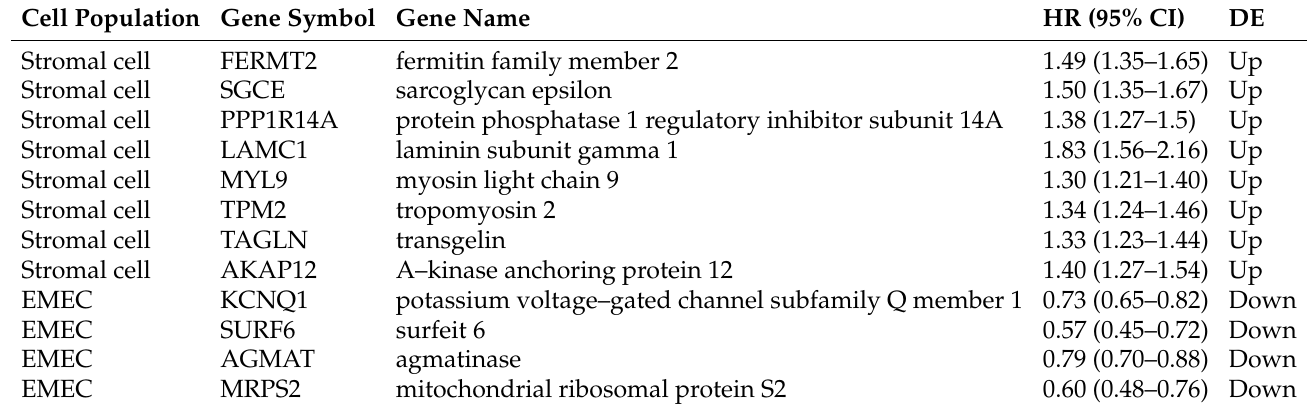
Table 5. Overview of prognostic gene signatures in stromal cell and EMEC subtypes. HR, hazard ratio; CI, confidence interval; DE, differential expression; Up (down), up- (down-) regulated in the TMEsubtype-H compared with TMEsubtype- M and